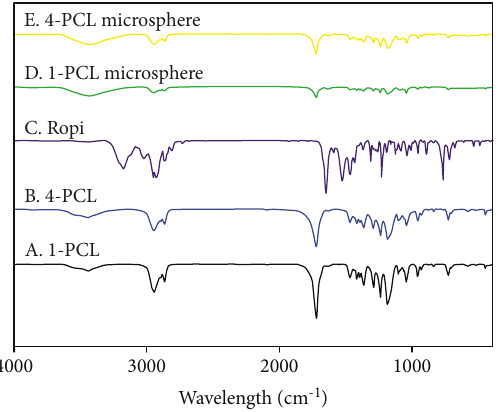
Figure 3: FT-IR spectra of blank 1-PCL (A), blank 4-PCL (B), Ropi (C), Ropi-loaded 1-PCL microsphere (D), and Ropi-loaded 4-PCL microsphere